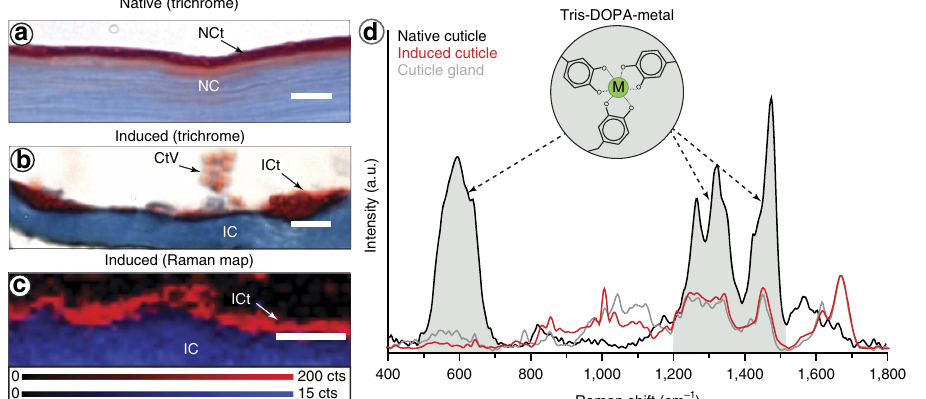
Figure 6 | Histological and Raman characterization of induced thread cuticle. ( a ) Trichrome-stained native thread section with blue-staining core (NC) and red-staining granular cuticle (NCt). Scale bar is 4 m m. ( b ) Trichrome-stained section of induced thread core and cuticle with blue-staining core (IC) and red-staining cuticle (ICt). Clustered cuticle vesicles (CtV) can be seen in the ventral groove before assembly. Scale bar is 4 m m. ( c ) Composite Raman confocal spectroscopic image of an induced thread integrated over two spectral regions corresponding to the induced core (blue; 1,226–1,299cm (cid:2) 1 ) and the induced cuticle (red; 1,600–1,630cm (cid:2) 1 ). Scale bar is 3 m m. ( d ) Comparison of Raman spectra from native cuticle, induced cuticle and cuticle gland. The intensities of the gland and induced spectra are normalized to the Amide I band height; however, the native cuticle spectra is not normalized due to the extremely high intensity of the DOPA-metal resonance